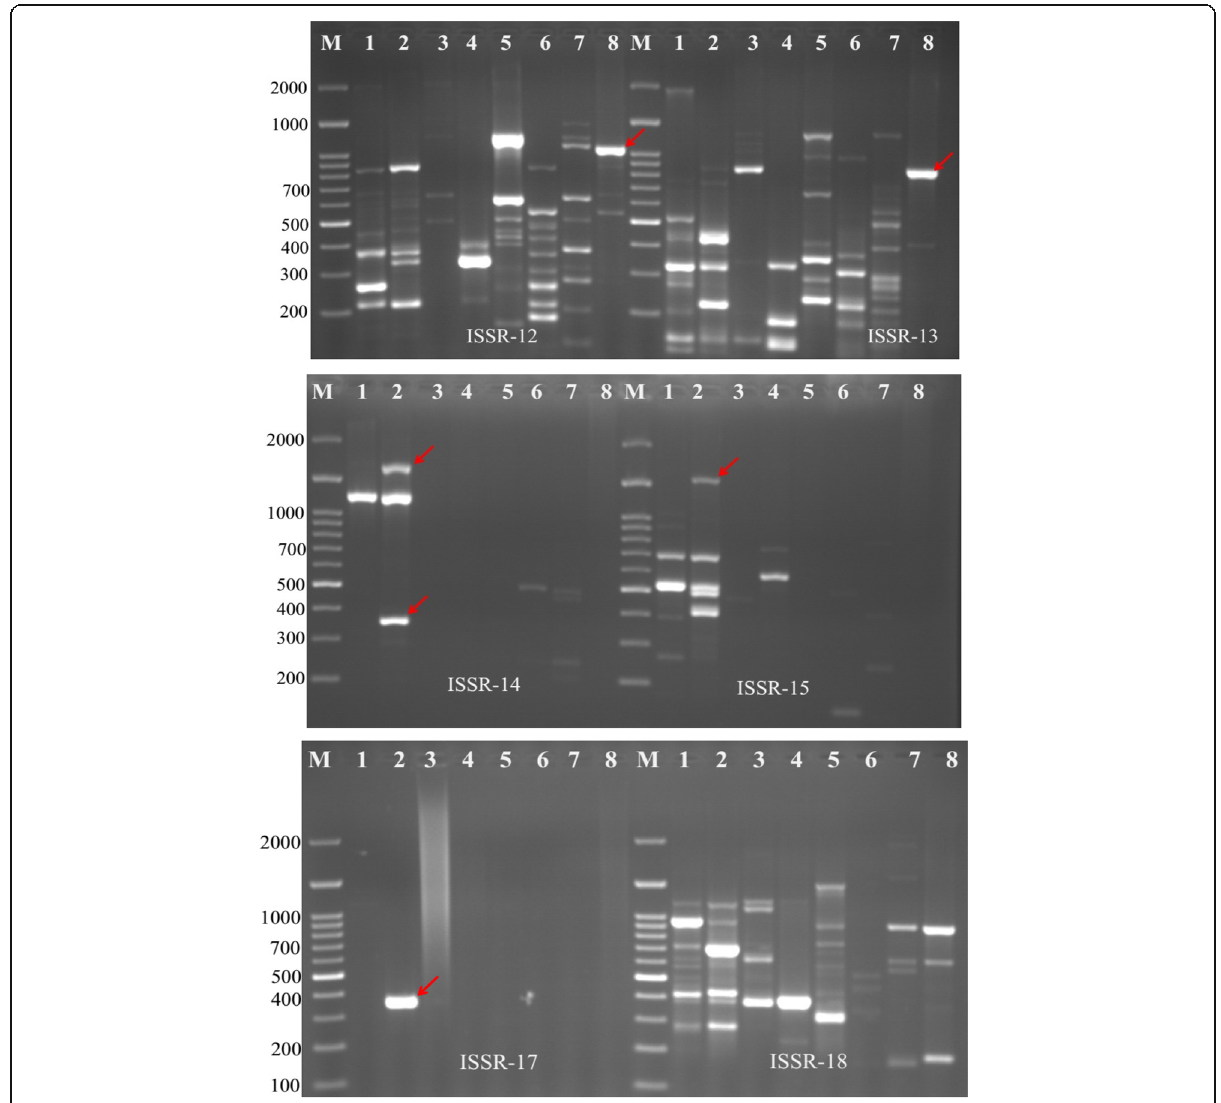
Fig. 4 ISSR-PCR profile of the eight Trichoderma strains using ISSR-12, ISSR-13, ISSR-14, ISSR-15, ISSR-17, and ISSR-18 primers. The amplification of DNA from the different species of Trichoderma was used for detecting the polymorphic bands among the isolates. The red arrows showed the species-specific bands in some Trichoderma spp. Lane 1, 100 bp DNA